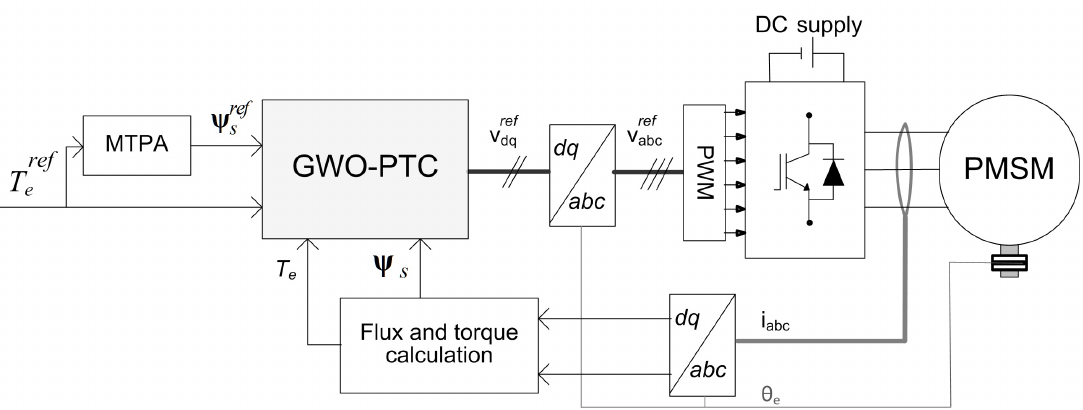
Figure 3. Schematic diagram of the proposed GWO-PTC